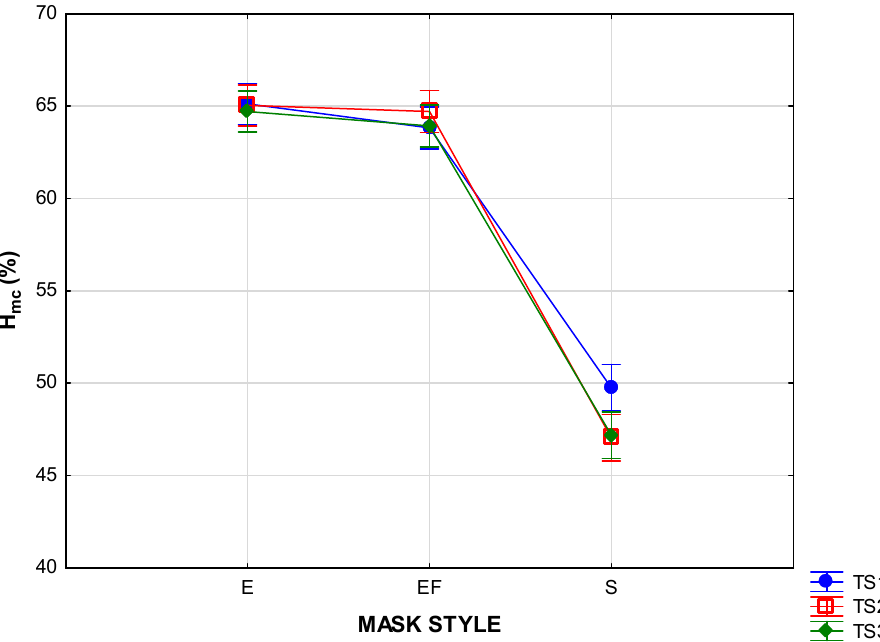
Figure 8. Two-way ANOVA of Hmc per mask style according to time segment.